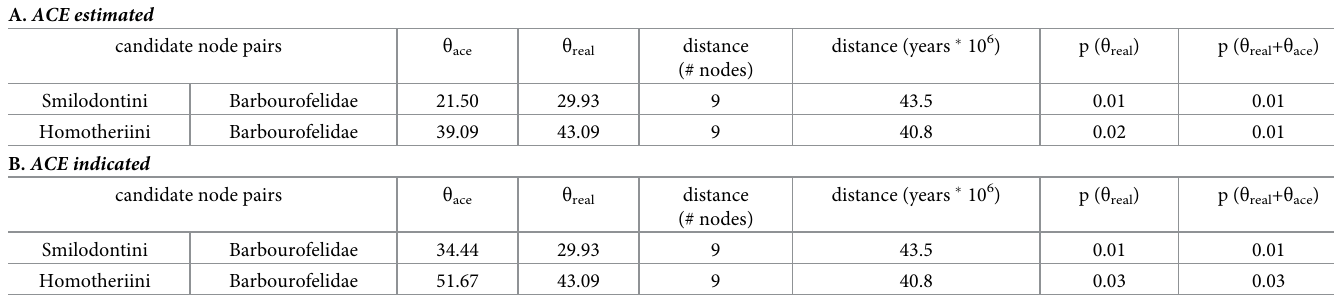
Table 2. The results of search . conv applied to felid mandibular shape.